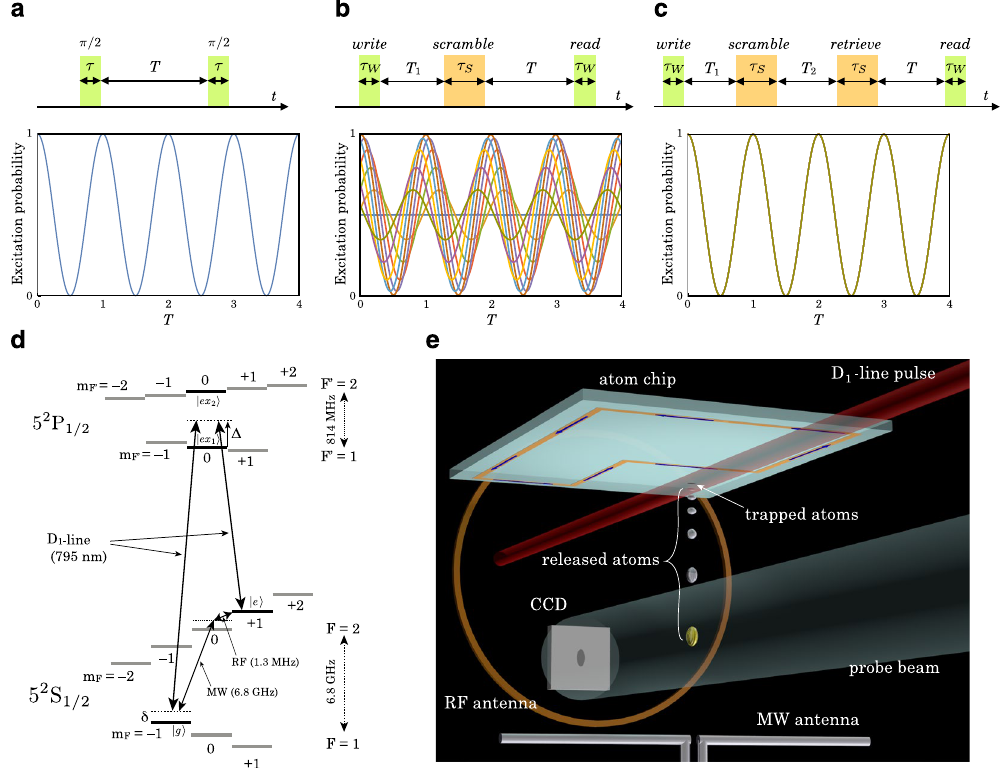
Figure 1. Security enhanced quantum memory. The horizontal axis T of the plot in ( a ), ( b ) and ( c ) is normalized with 2 π / δ j . ( a ) Pulse sequence of the Ramsey interferometry and the calculated excitation probability of the Ramsey flop. ( b ) Scrambling pulse sequence and the calculated excitation probability. The excitation probability includes several curves calculated with a phase difference φ S ∈ [0, 2 π ]. ( c ) Scramble- retrieve pulse sequence and the calculated excitation probability. The excitation probability includes several curves with a phase difference φ S ∈ [0, 2 π ]. ( d ) Relevant energy level for the stimulated Raman transition using D 1 -line / MW-RF fields. ( e ) Illustration of the experimental setup for security enhanced quantum memory. D 1 -line, MW, and RF fields are applied when atoms are trapped in a magnetic potential below the atom chip. Excitation probability is measured after a 16 ms TOF with state selective absorption